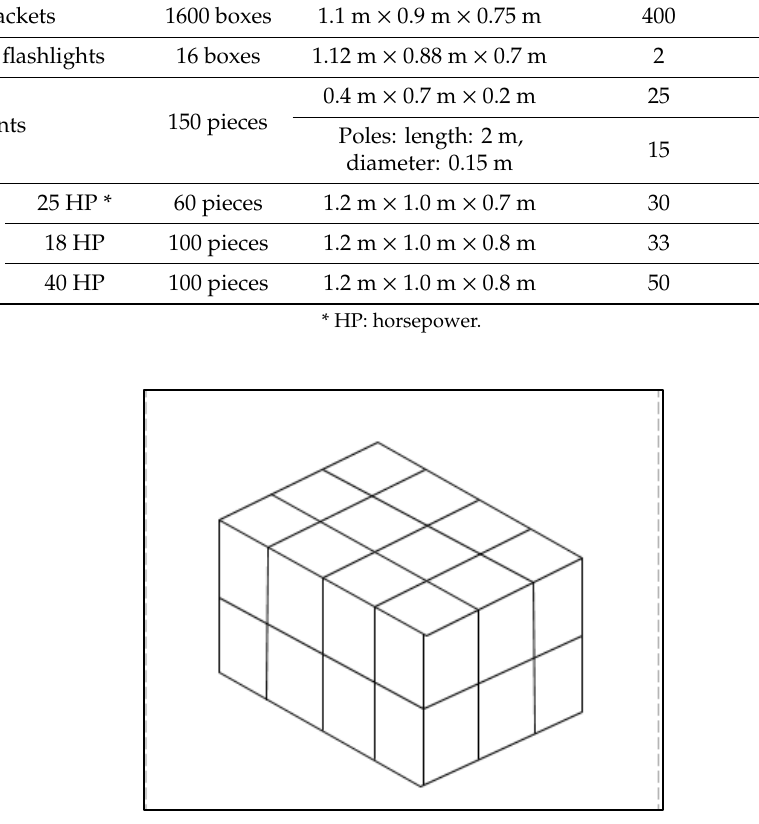
Figure 2. Motor oil stacking model.